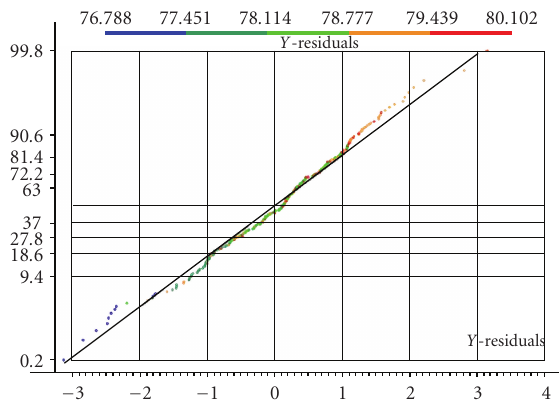
Figure 2: Y -residuals normal probability plot.